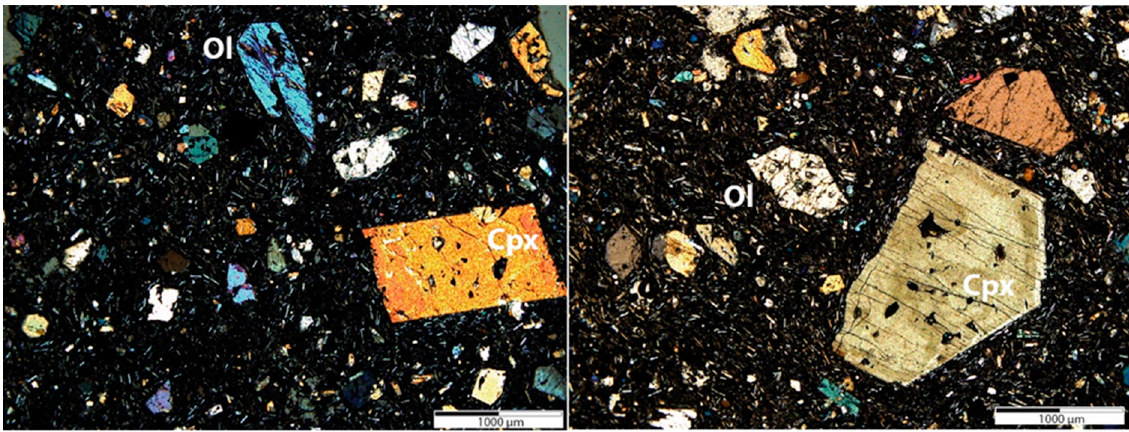
Figure 2. Photomicrographs under plane-polarized light illustrating lava flows formed in November, 2021 from Cumbre Vieja, La Palma.